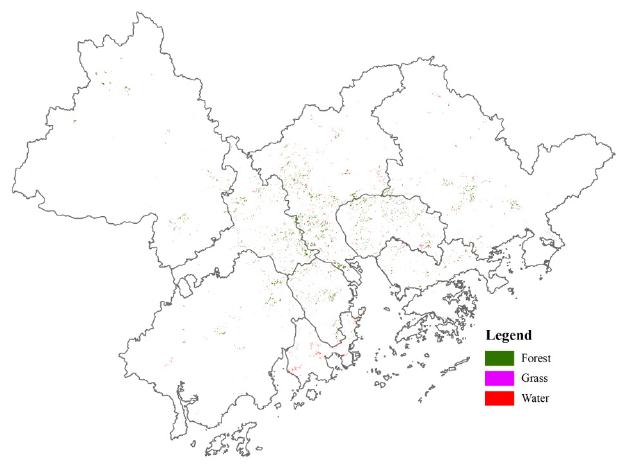
Figure 4. The allocation of the new green and blue spaces. Table 2. The changes of ES supply and demand under optimized land use allocation.